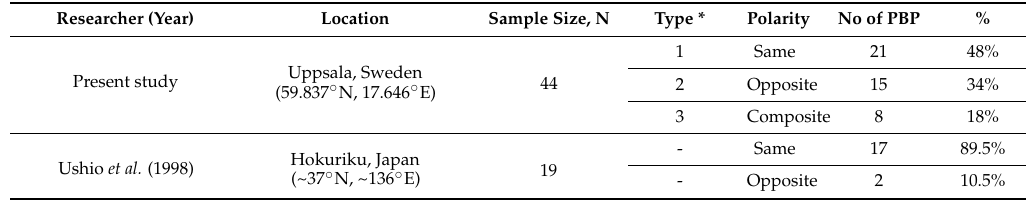
Table 3. Percentage of PBP according to initial half cycle